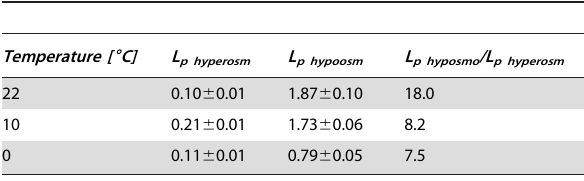
Table 2. L p values and their ratios, determined under hyper- and hypotonic conditions at 0, 10 and 22 u